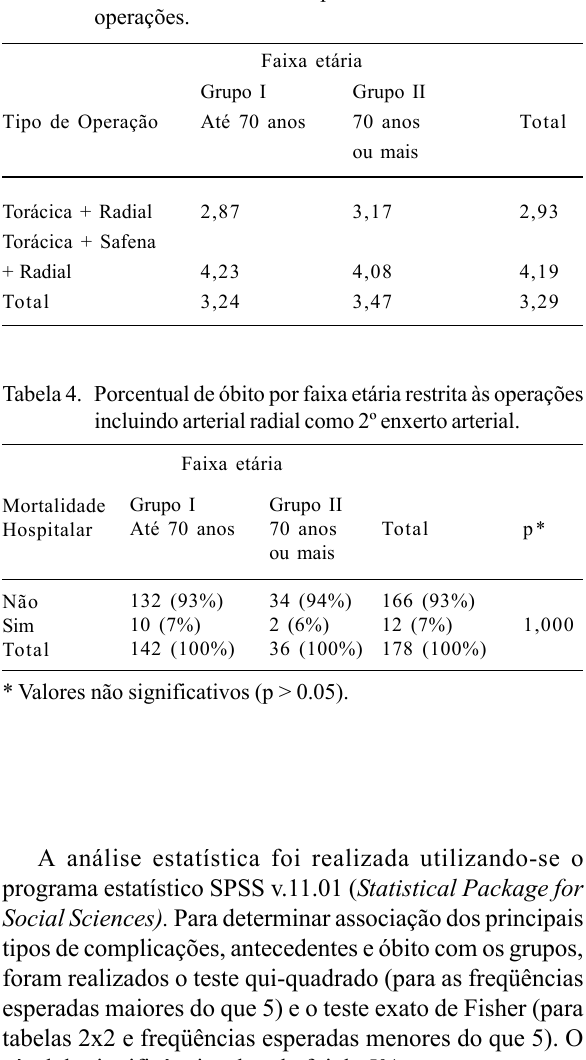
Tabela 1. Análise comparativa de complicações em pacientes Tabela 3. Média de anastomose por faixa etária restrita às